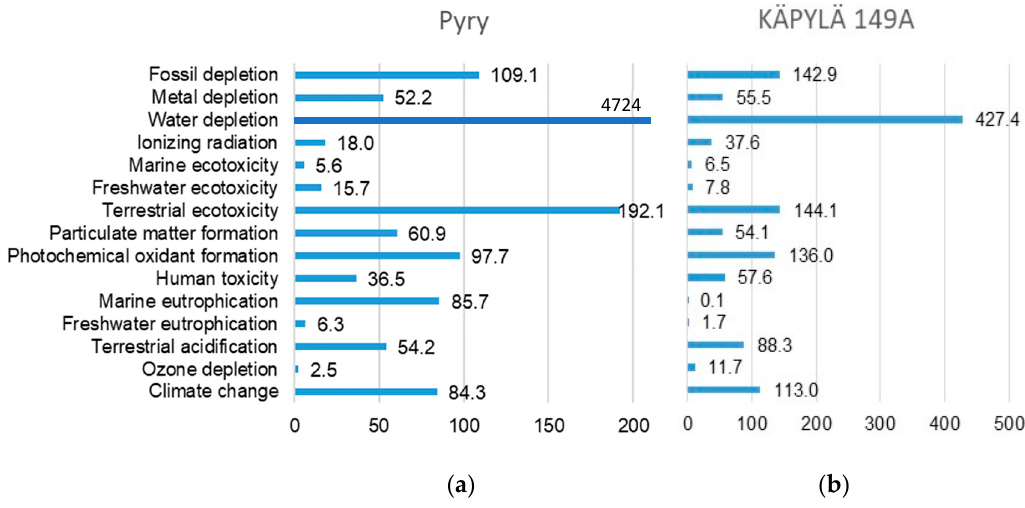
Figure 1. ( a , b ): Assessment results for Pyry and KÄPYLÄ, GaBi estimates when SimaPro = 100. Table 3. Assessment results per square meter from GaBi and SimaPro in absolute and relative terms in the fifteen impact